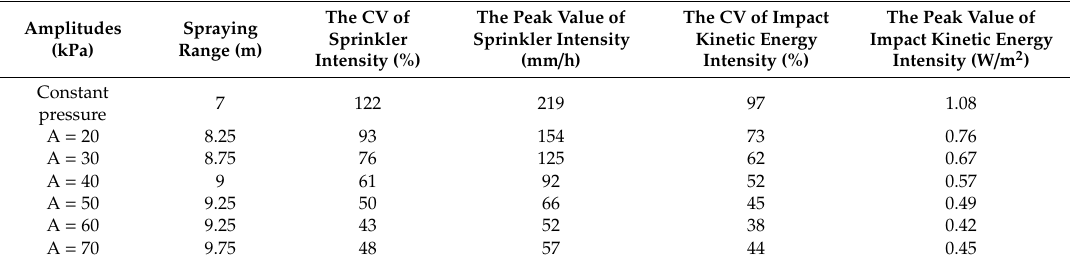
Figure 7. The radial distribution of sprinkler intensity ( a ) and impact kinetic energy intensity ( b ) under constant and dynamic water pressure. The average water pressure is 100 kPa. Table 1. The testing parameter of radial distribution of sprinkler intensity and impact kinetic energy intensity under constant and dynamic water